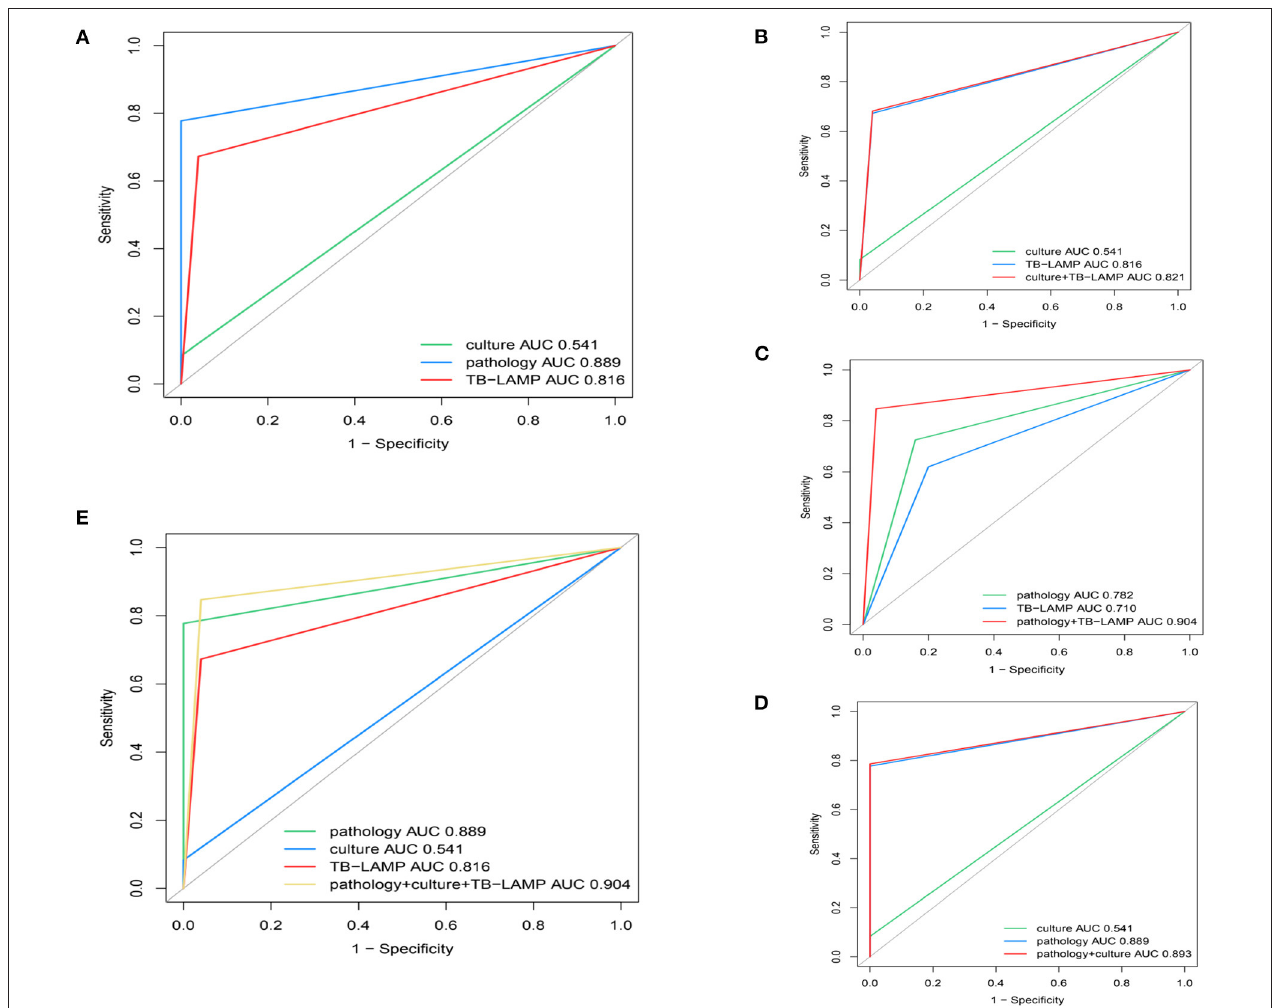
FIGURE 5 | Receiver operating characteristic (ROC) curves for determining the sensitivity and specificity of (A) culture, TB-LAMP and pathology using CCRS as a reference (B) culture, TB-LAMP and the two tests in parallel using CCRS as a reference (C) pathology, TB-LAMP and the two tests in parallel using CCRS as a reference (D) pathology, culture and the two tests in parallel using CCRS as a reference (E) culture, TB-LAMP, pathology and the three tests in parallel using CCRS as a reference. TB-LAMP: Loop-mediated Isothermal Amplification Assay; CCRS: composite clinical reference